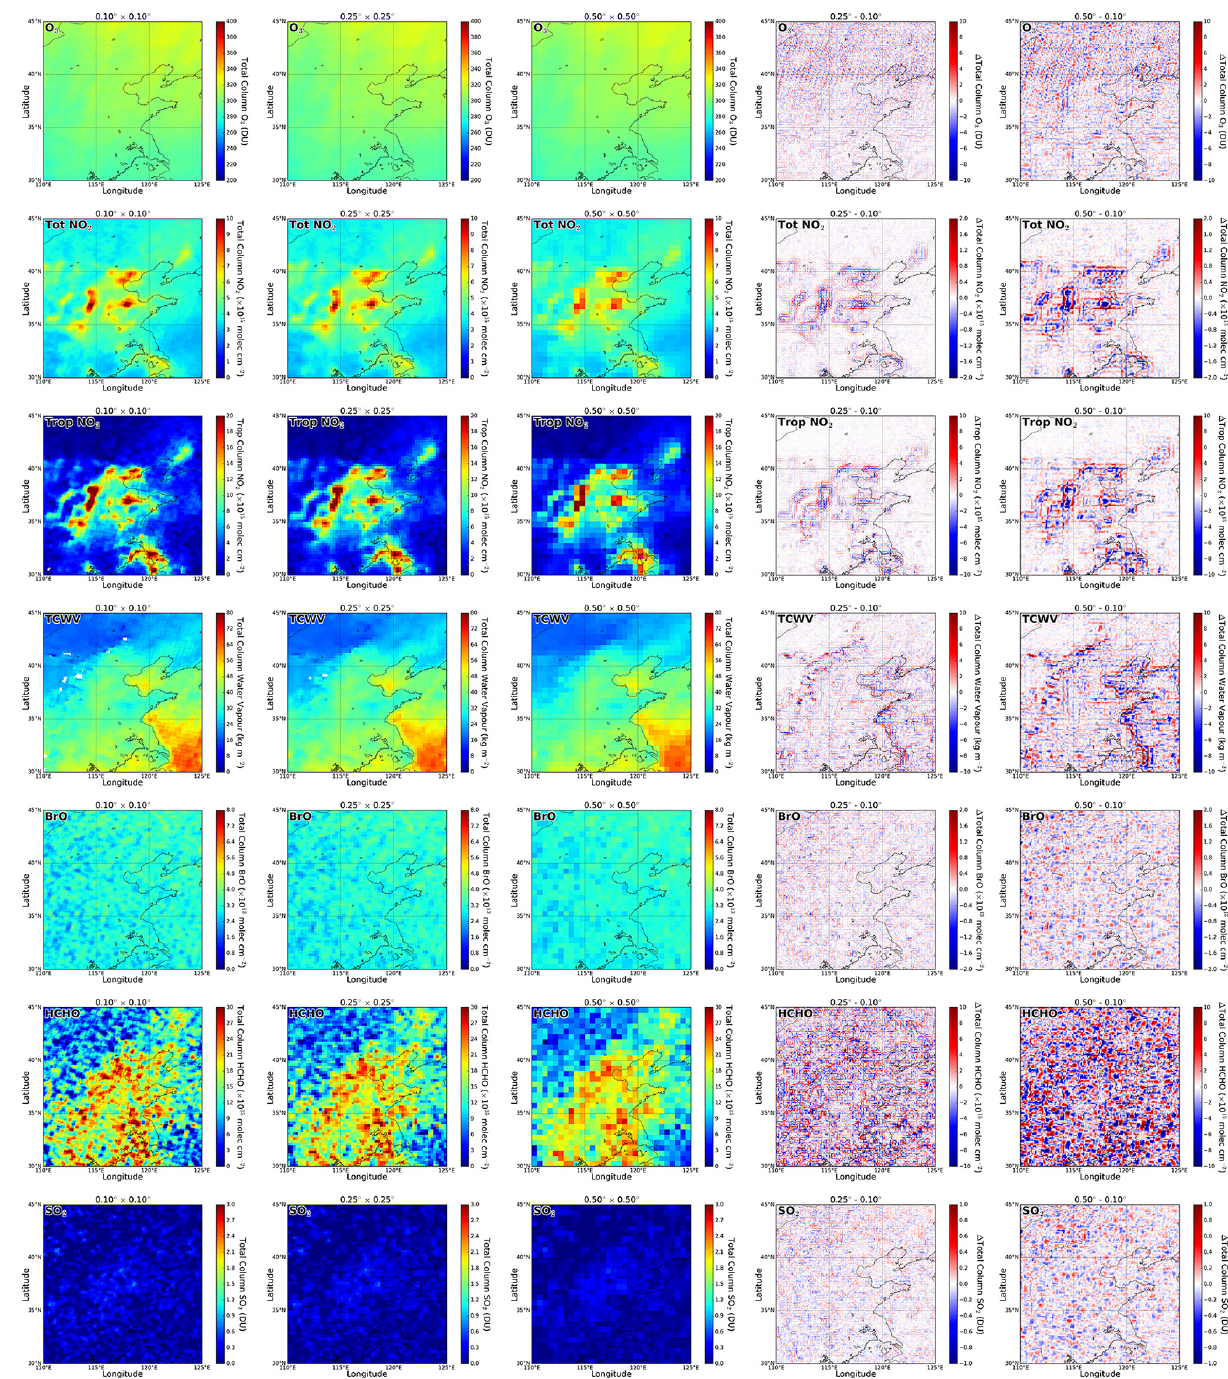
Figure 3. Monthly averaged GOME-2A observations of total column O 3 (first row), total column NO 2 (second row), tropospheric column NO 2 (third row), total column water (fourth row), vapour total column BrO (fifth row), total column HCHO (sixth row), and total column SO 2 (seventh row) over North China in July 2014. Gridded data with 0.1 ◦ × 0.1 ◦ resolution (first column from the left), 0.25 ◦ × 0.25 ◦ resolution (second column from the left), and 0.5 ◦ × 0.5 ◦ resolution (third column from the left) are shown. Differences between 0.1 ◦ , 0.25 ◦ , and 0.5 ◦ are also shown for reference.